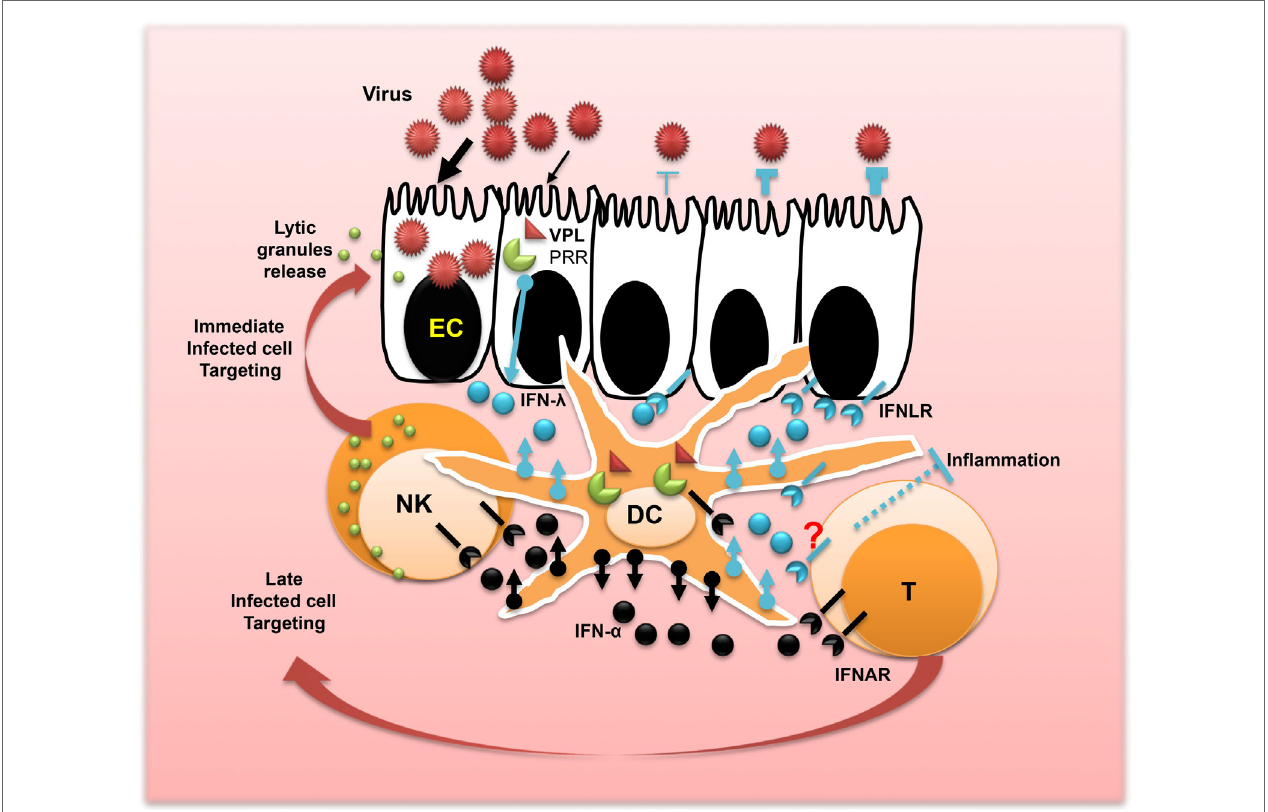
FiGURe 2 | Concerted action of iFN- λ and iFN- α promotes mucosal immunity and viral protection . After the interaction of the epithelium surface of the mucosa with viruses, epithelial cells release IFN- λ . The process leading to IFN- λ production is triggered by the interaction of a viral particle ligand (VPL) such as DNA or RNA with the cellular pattern recognition receptors. Dendritic cells (DCs) are the main immune cells of the mucosa involved in sensing viral infections and producing high amounts of IFN- λ and IFN- α . This produced IFN- λ fuels the antiviral protection of the epithelium and in concert with IFN- α may shape local immunity and control inflammation. Released IFN- α by DCs also plays a central role in controlling viral dissemination in the lamina propria and the promotion of T cell immunity and natural killer cell activation for immediate targeting and clearance of infected cells toward stopping viral